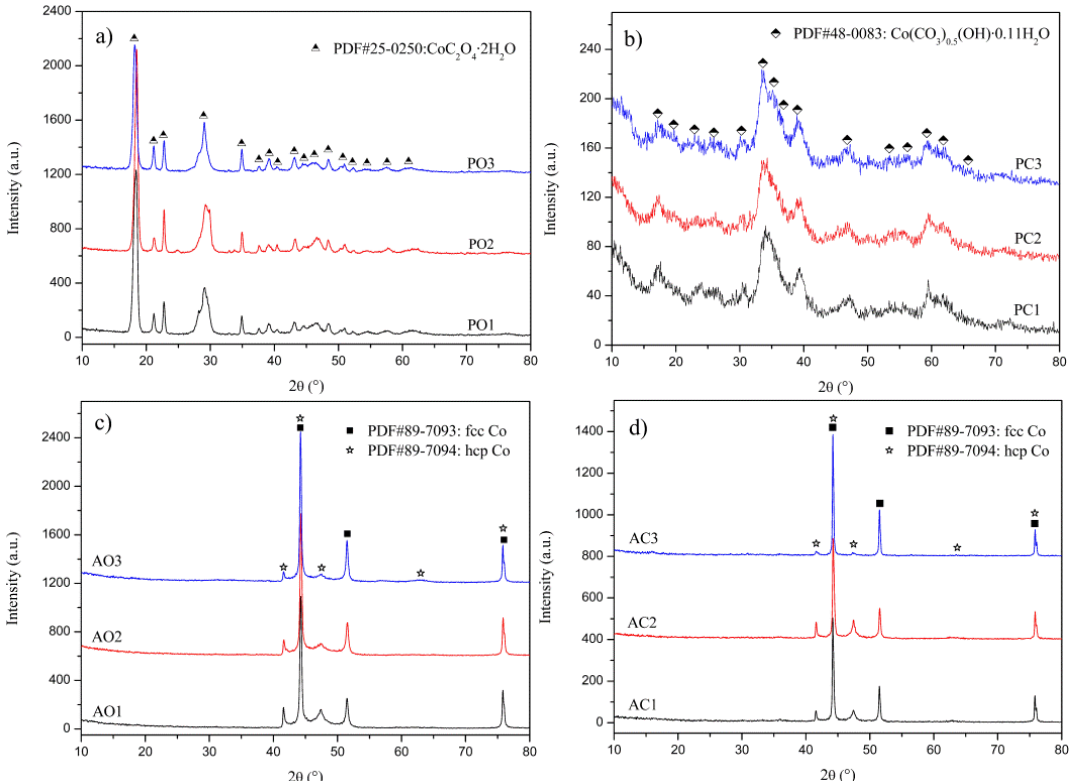
Figure 2. XRD patterns of :( a , b ) precursors; and ( c , d ) Co-Cr-V alloy powders.